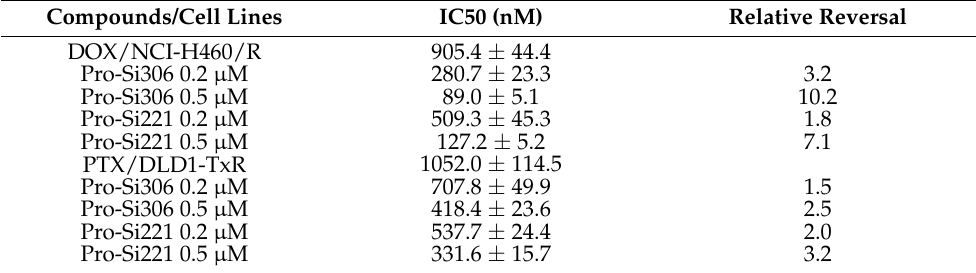
Table 5. Relative reversal of DOX and PTX resistance in NCI-H460/R and DLD1-TxR cells induced by SFK